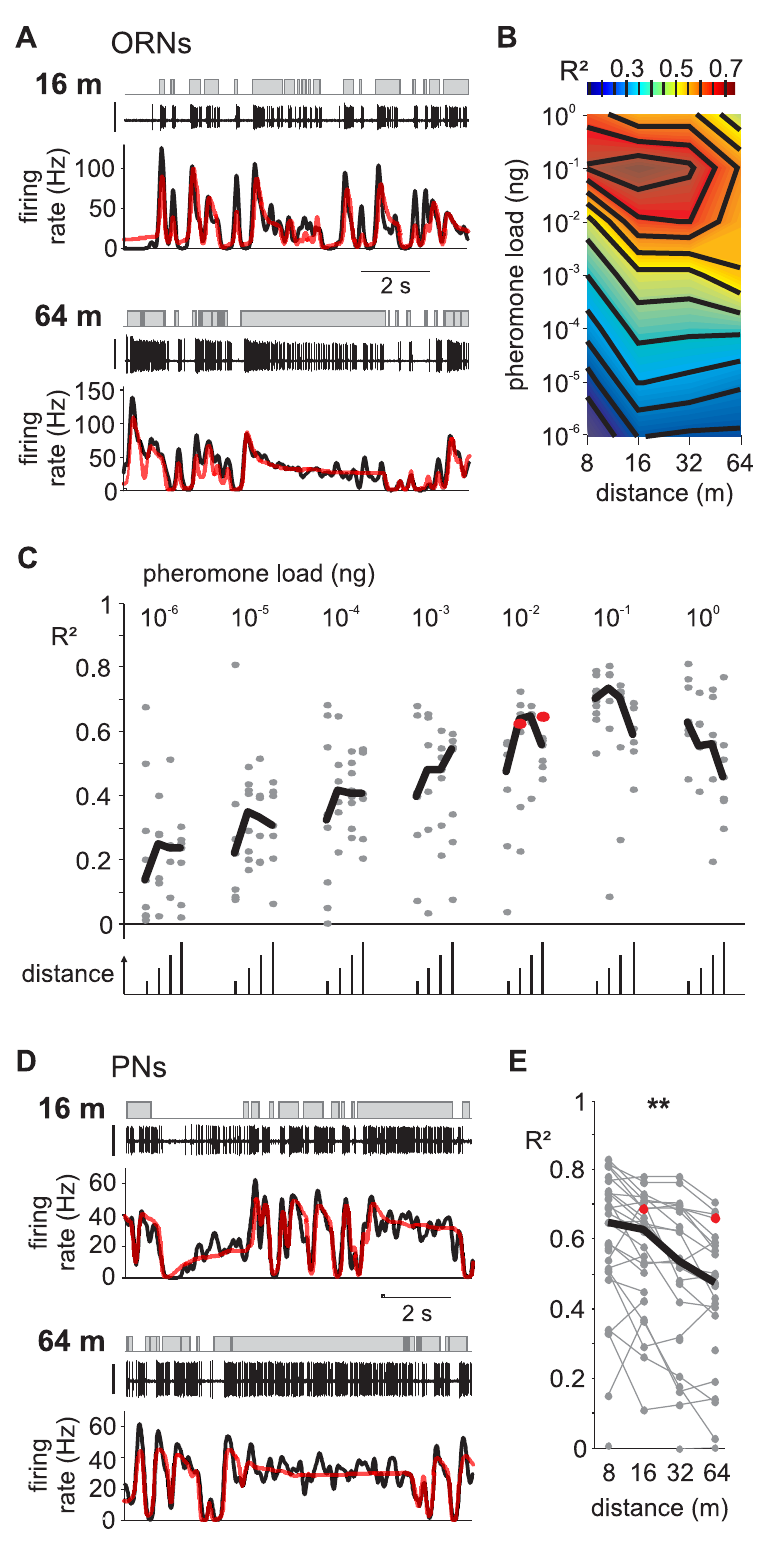
Fig 7. L-N model performancevaries with the simulated distance during turbulent stimuli. (A) Response of two ORNs to turbulent stimuli simulatingdistances of 16 m (top, R 2 = 0.63) and 64 m (bottom, R 2 = 0.65). Same conventions as in Fig 1B. (B) Heatmap of the median coefficient of determination( R 2